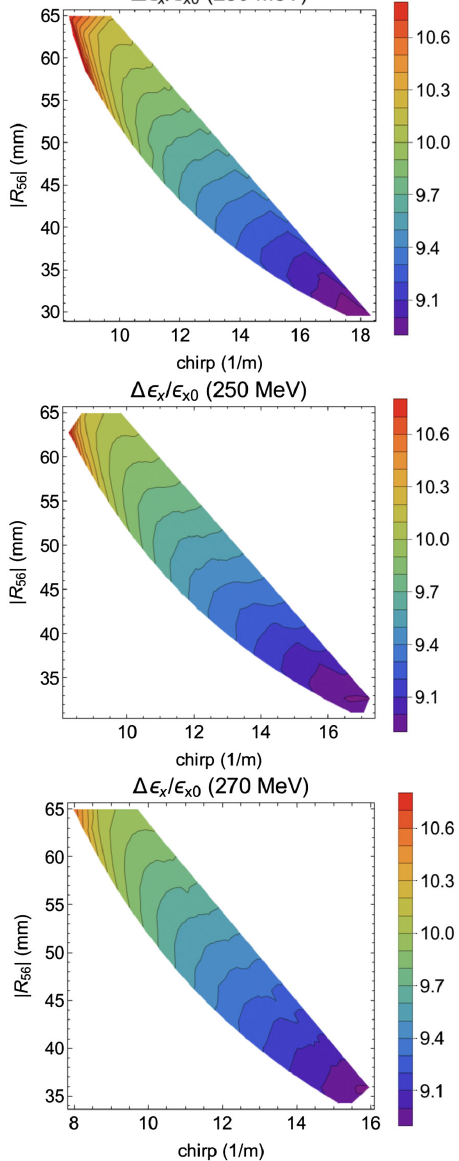
FIG. 8. The estimated emittance growth after BC1, with varying BC1 R 56 and linear chirp at the BC1 entrance for BC1 energy 230 MeV (top), 250 MeV (middle) and 270 MeV